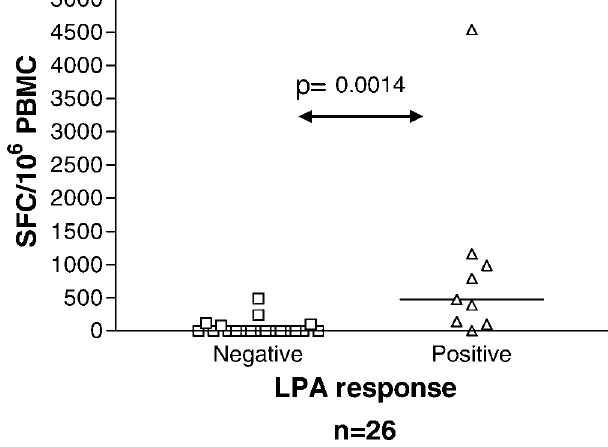
Figure 5. Relationship of CD4 þ T cell Proliferation against HCV Antigens to CD8 þ IFN- c